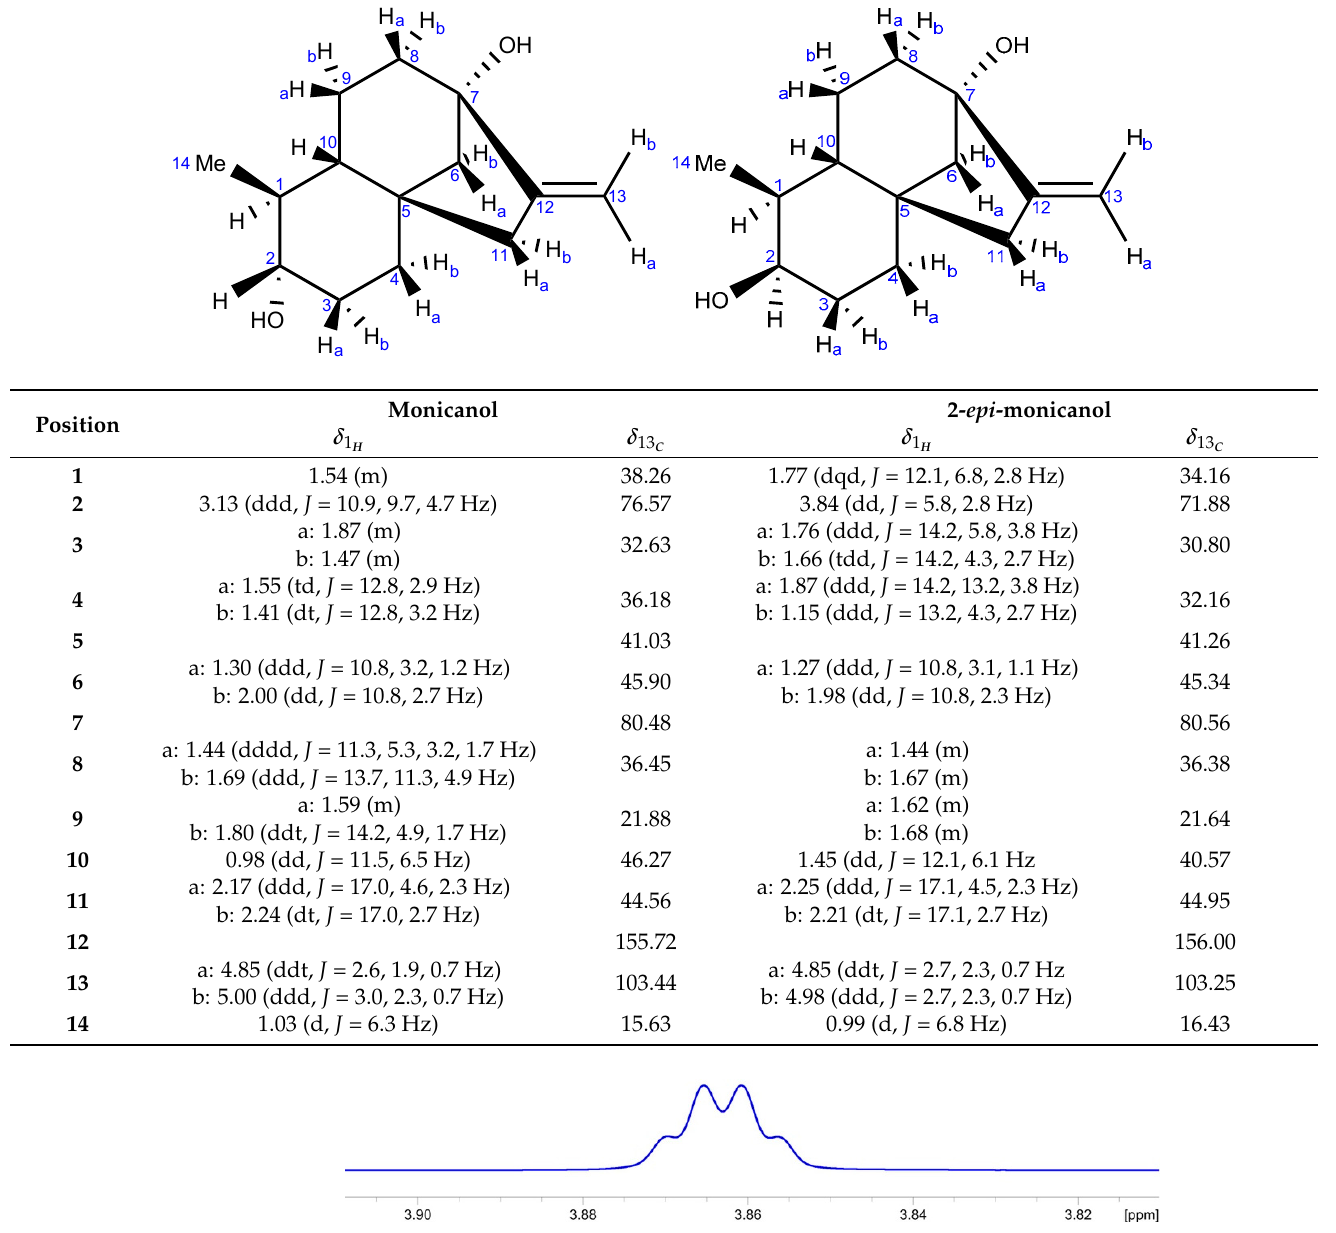
Table 3. 1 H (600 MHz) and 13 C (151 MHz) NMR data for monicanol and 2- epi -monicanol. Spectra are recorded at 298 K in CDCl 3 . Coupling constants are matched amongst the different multiplets. For the unmatched coupling constants, please